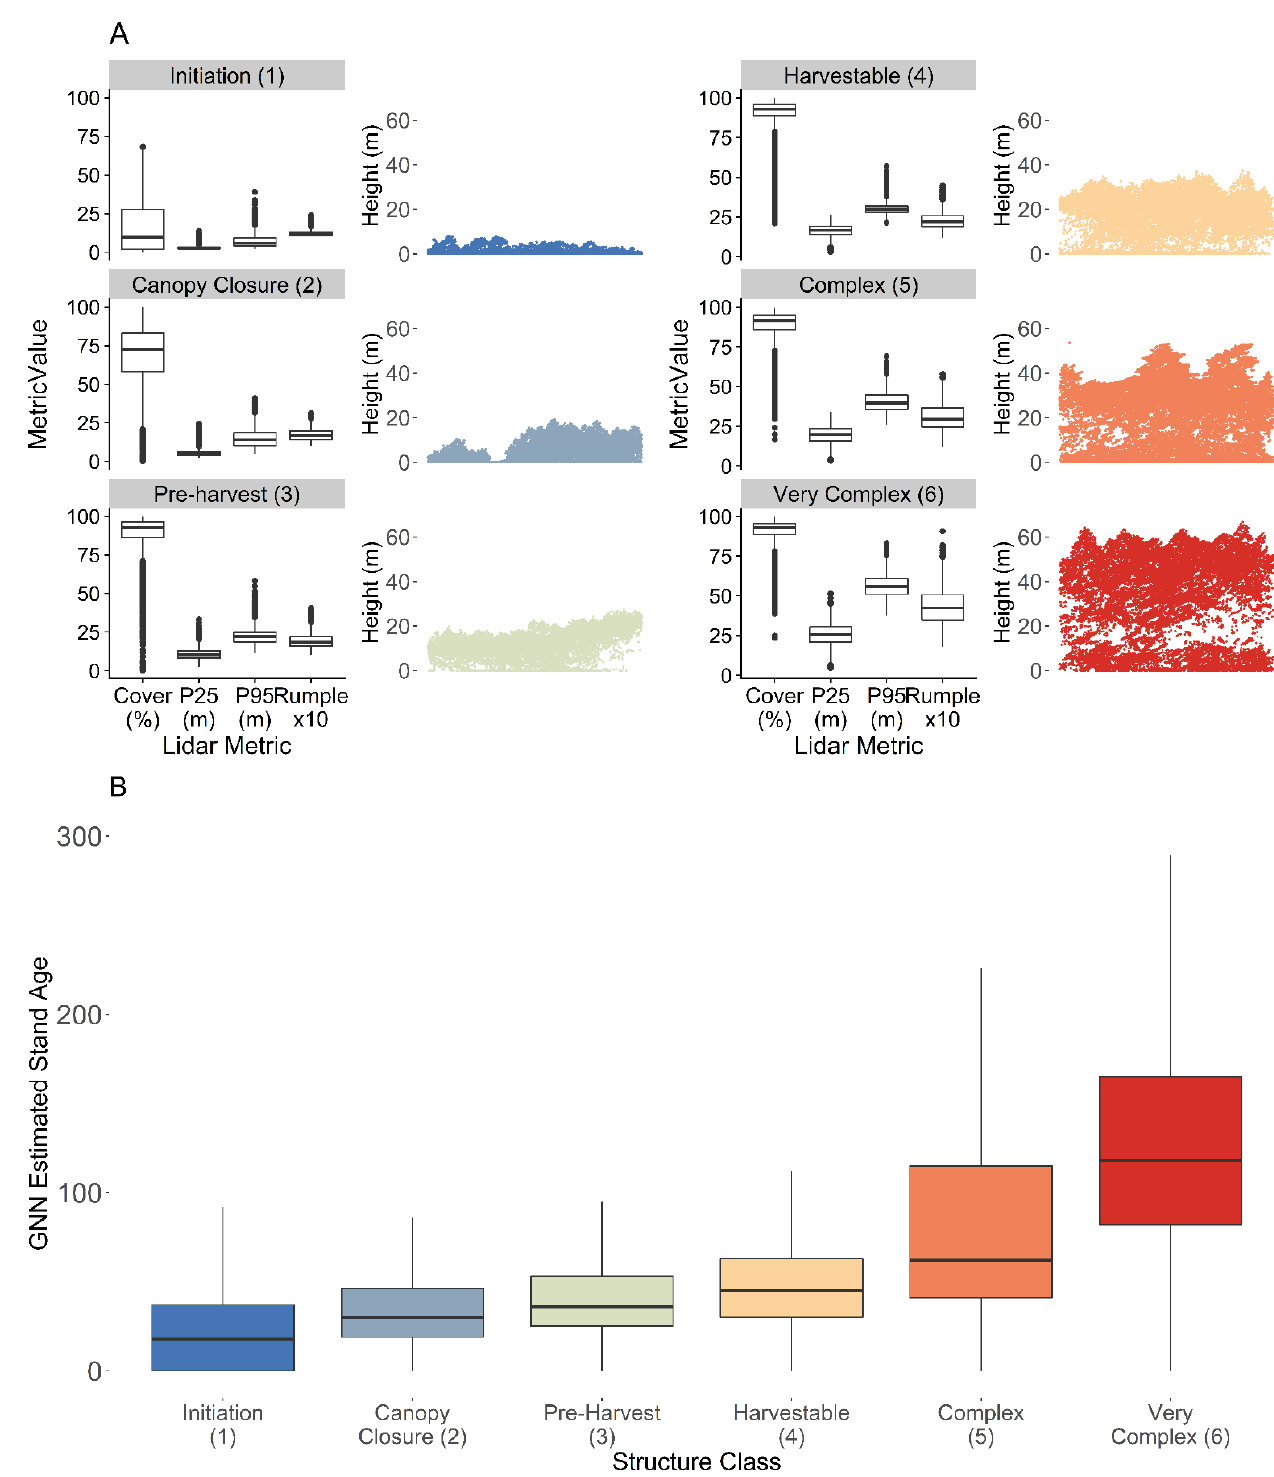
Figure 2. ( A ) Distribution of lidar metric values within each forest structure class identified in the study and transects of lidar point clouds representative of each forest structure class. These classes lie on a spectrum of structurally simple to structurally complex, evidenced by the linear increase in P95, P25, and rumple from the Initiation to Very Complex classes. ( B ) Boxplots of GNN stand age estimates across the six forest structure classes [88]. Stand age estimates generally increase as structural complexity increased from Initiation to Very Complex (Classes 1 through 6) classes.